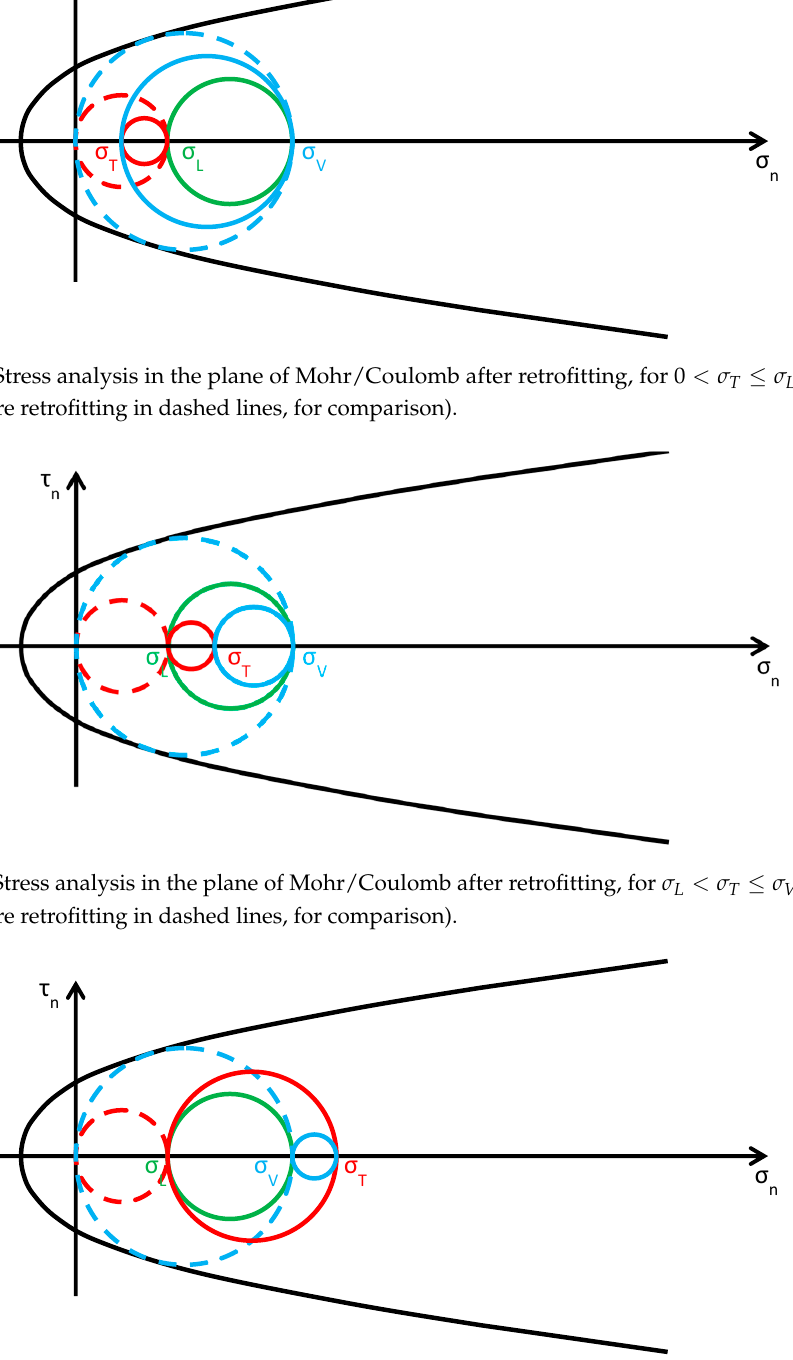
Figure 18. Stress analysis in the plane of Mohr/Coulomb after retrofitting, for σ T > σ V (Mohr’s circles before retrofitting in dashed lines, for comparison).